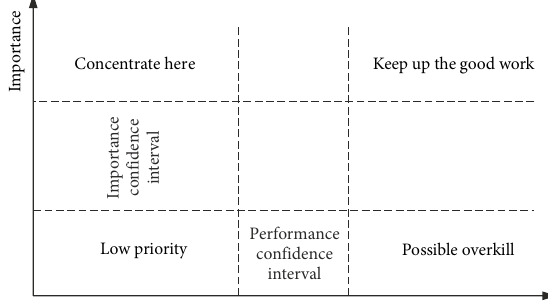
Figure 2. Confidence intervals in standard IPA